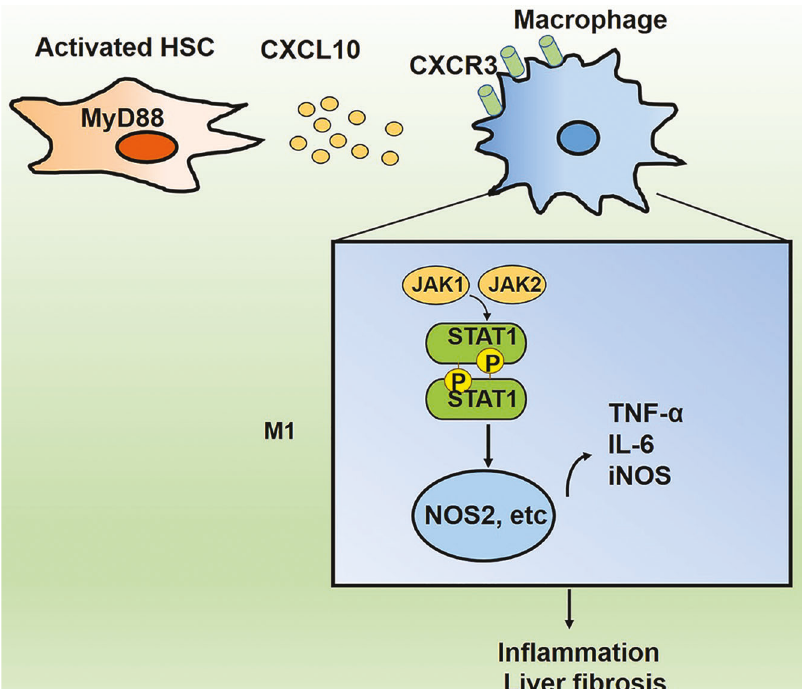
Fig. 8 Schematic of MyD88 signaling in HSCs in fi brosis model. MyD88 in HSCs promotes CXCL10 secretion. CXCL10 further induces macrophage M1 polarization through activation of JAK/STAT1 signaling pathway, which in turn promotes liver in fl ammatory response and fi